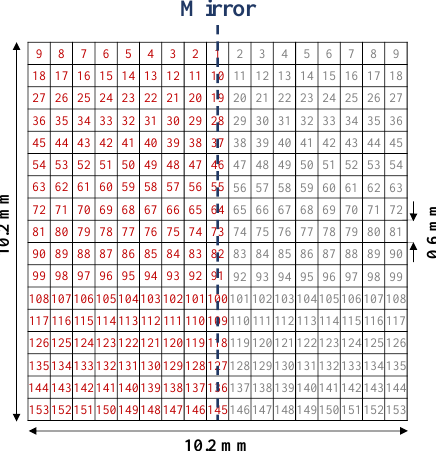
Figure 18. Pixelization of the sensing area. Reprinted with permission from Ref.